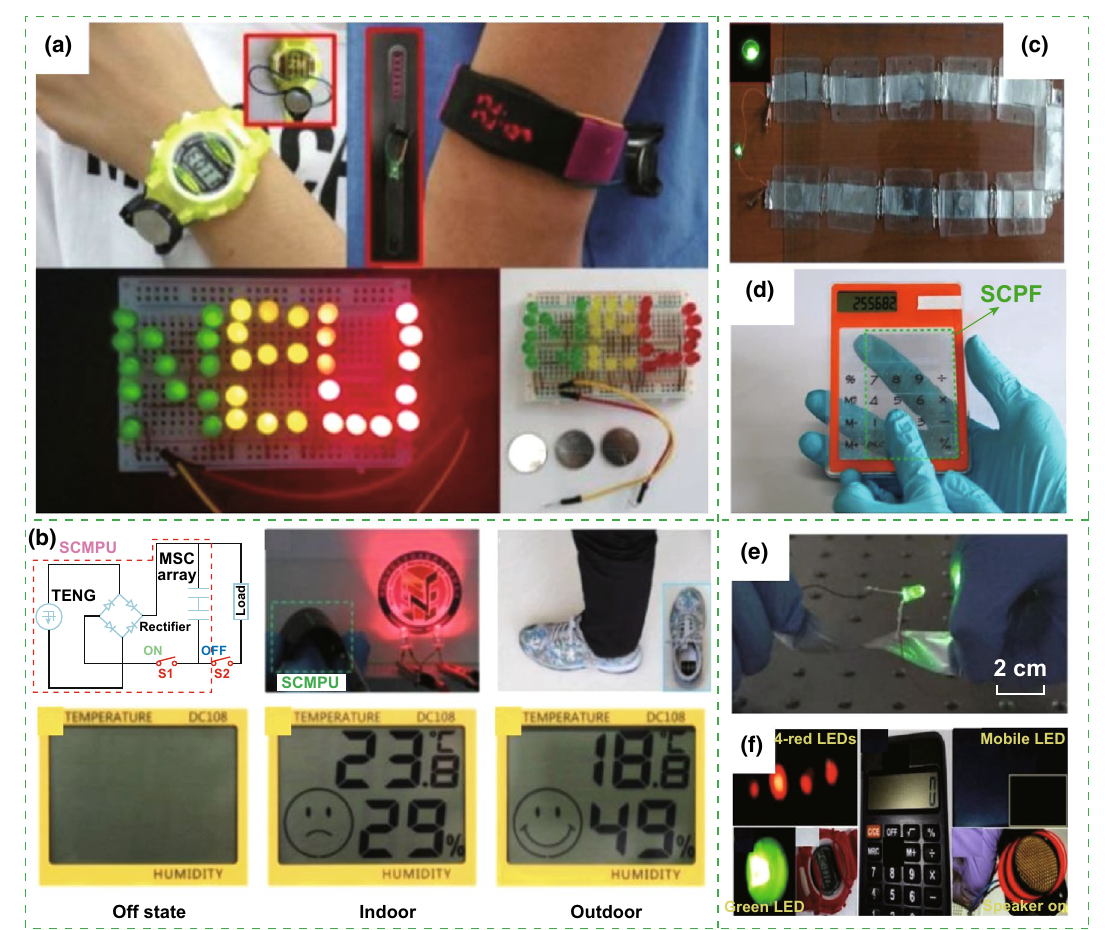
Fig. 13 a The all‑solid‑state SCPC can power smartwatch, sports bracelet, and LEDs. Reprinted with permission from Ref. [11]. b Circuit dia‑ gram of the energy supply mode and photographs of showing two LEDs being powered by the SCMPU, the SCMPU inserted in the insole of a shoe and using the SCMPU to drive a commercial hygrothermograph. Reprinted with permission from Ref. [15]. c Operation of green light‑ emitting diode using serially connected SCSPCs as the power source. Reprinted with permission from Ref. [17]. d Photograph of a calculator driven by the SCPF. Reprinted with permission from Ref. [18]. e Photographs of the twisted Li‑ion battery to light up a green LED. Reprinted with permission from Ref. [19]. f Photographs of the fabricated devices can instantaneous lightning of four commercial red LEDs upon repeated finger imparting and lightning of a green LED light with adequate intensity. Meanwhile, power‑up small electronic wrist watch, commercial digital calculator, mobile LCD screen, and portable speaker. Reprinted with permission from Ref.